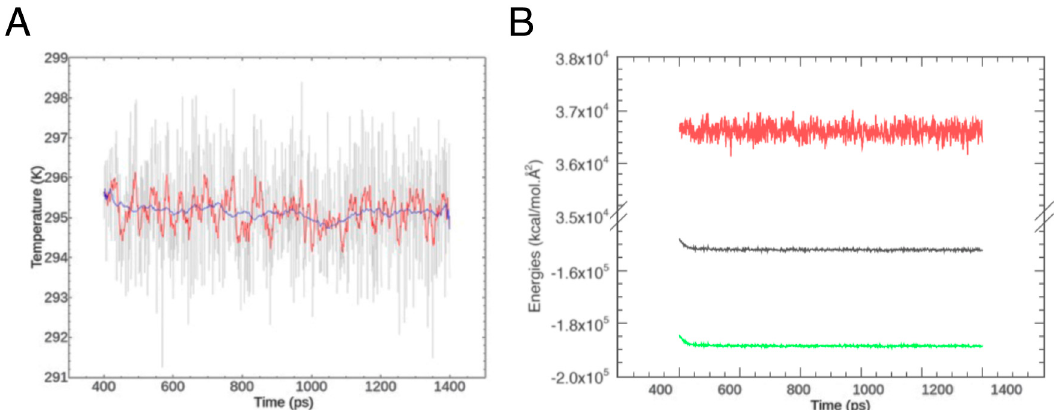
Figure 2. Equilibration of the PIN2 loop. ( A ) Behavior of system temperature over the equilibration period. The full raw data are in grey, while the red and blue lines show window averages over 10 and 100 ps, respectively; ( B ) Potential energy (green), kinetic energy (red) and total energy (black) of the system over the same period.